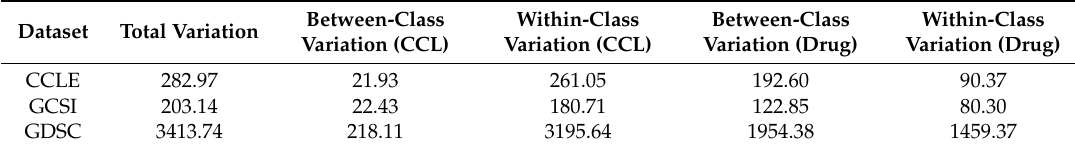
Table 3. Comparison of between-class and within-class drug response variations with CCLs and drugs taken as